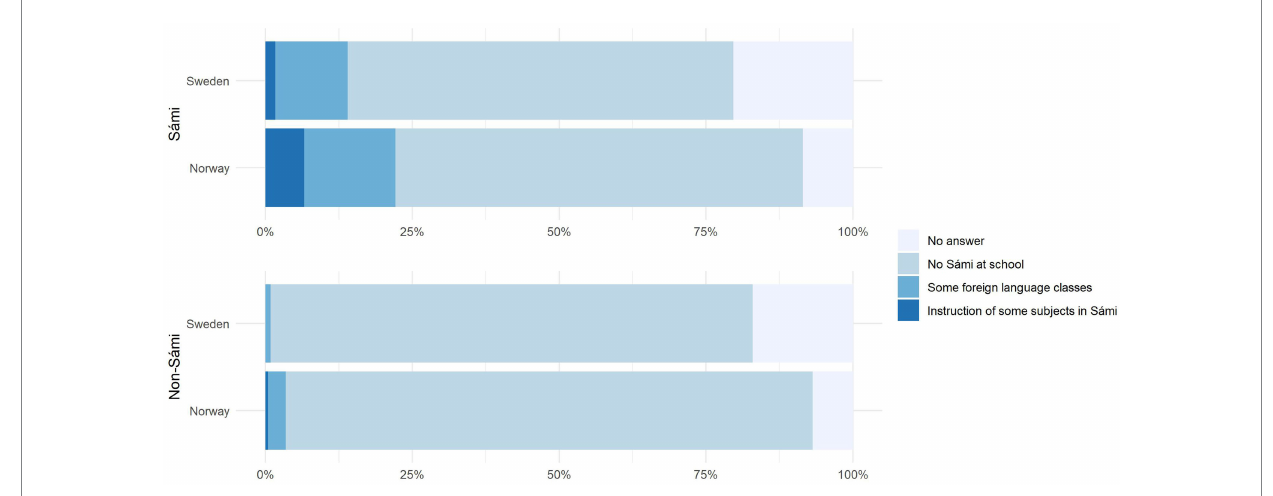
FIGURE 4 Self-reported Sámi learning at school by country and ethnicity.